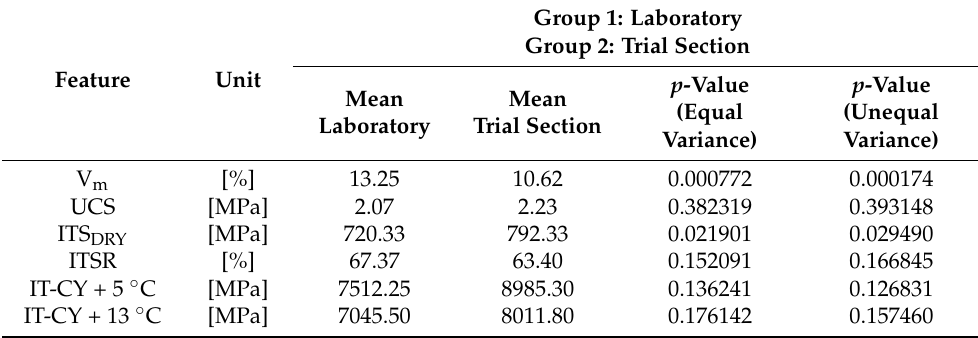
Table 5. Student t -test for comparisons of the mean values for specimens prepared in the laboratory and specimens collected from the trial section for the CRM-FB base with the 5C binder. Group 1: Feature Unit